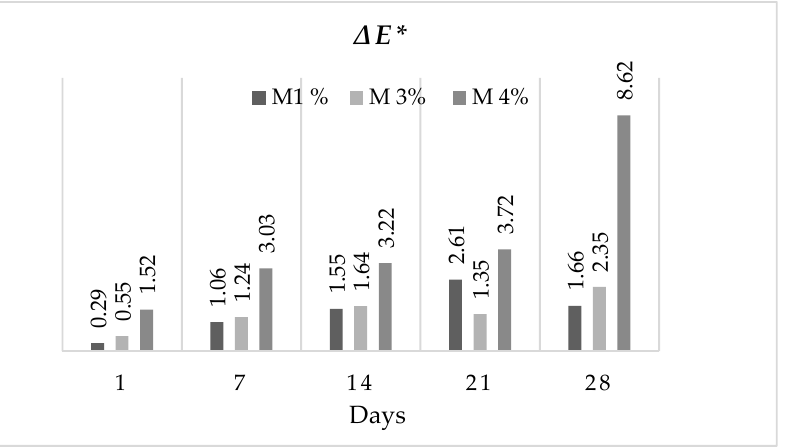
Figure 3. The total colour difference ( Δ E* ) of yoghurt samples without (Control) and with the addition of moringa extract (M 1%, M 3% and M 4%) after 1st, 7th, 14th, 21st and 28th day of cold storage. The total colour difference ( Δ E* ) is a psychophysical difference noticeable by the observer, determined by the observation of two samples. When ∆ E* values are >3.00, the difference from the control sample is visible to the human eye [17]. On the 1st day of cold storage, there were no noticeable differences between the samples when compared to the control sample. Until the end of the cold storage period, samples with 1% and 3% ME did not differ from the control sample. However, the yoghurt with 4% ME was noticeably different from the 7th day till the end of the storage when the Δ E* was the highest (8.62). Zhang et al. [7] measured L* , a* and b* on the 1st day of storage and their data showed decreased redness and increased yellowness in ME-supplemented yoghurt without any changes in lightness. Thereby, the amounts of added ME ranged from 0.05% to 0.2% and did not induce colour changes in the yoghurts. Furthermore, Bikheet et al. [30] reported that the addition of moringa water and ethanol extract (1%, 4% and 5%) to yoghurt signif- of the b* parameter.